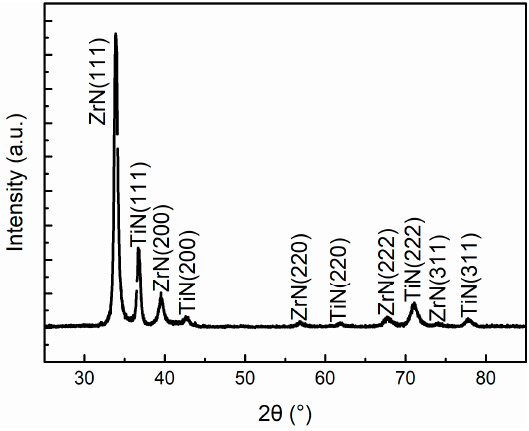
Figure 17. XRD diffractogram of TiN/ZrN coating after hot corrosion for 4 h. Figure 18. SEM image of TiN/ZrN coating after hot corrosion for 4 h.